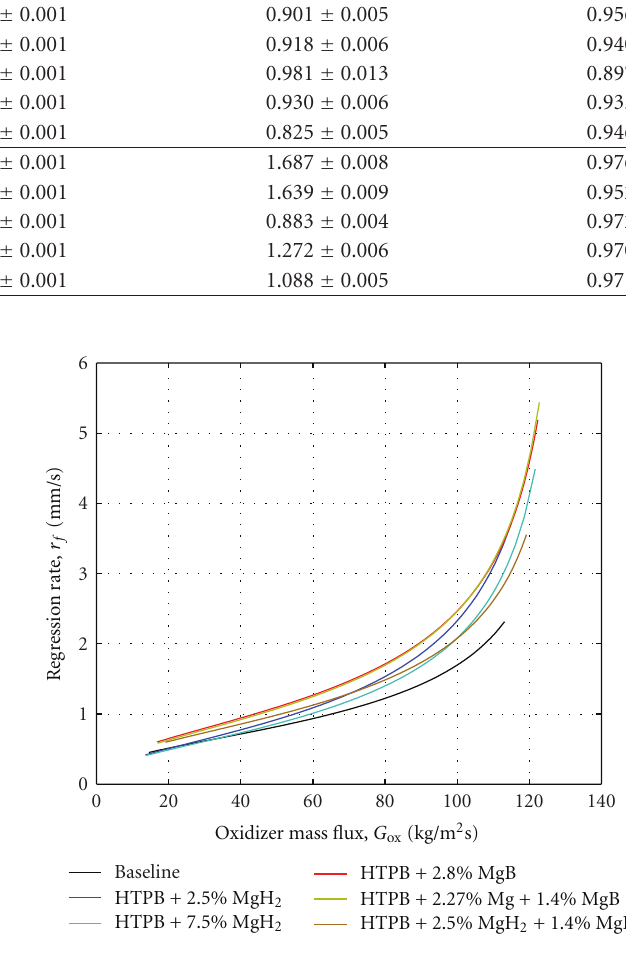
Figure 10: Magnesium-loaded formulations: ensemble average, experimental data r f ( G ox ) compared to baseline. Error bars are not reported to improve